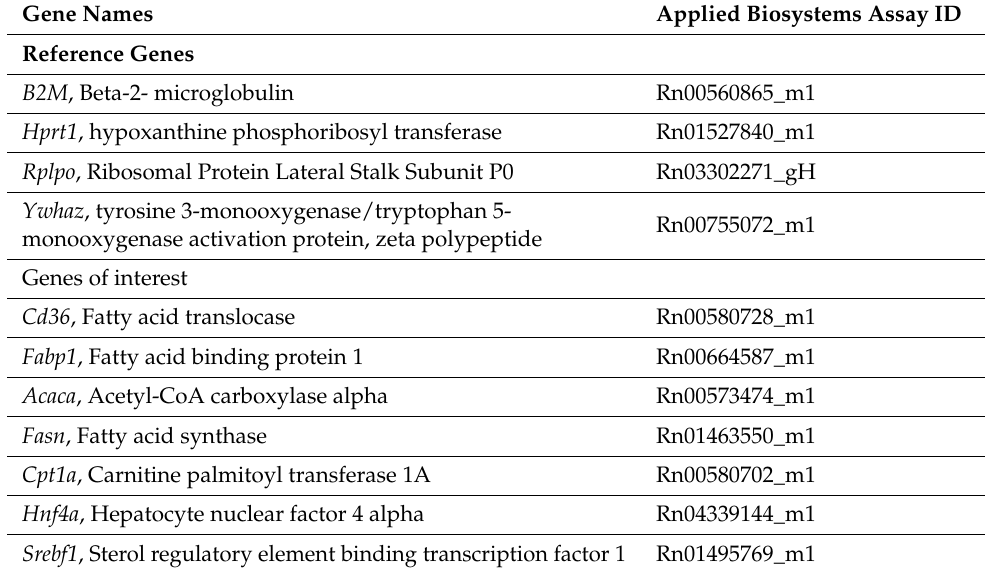
Table 2. Genes selected for RT-qPCR in the